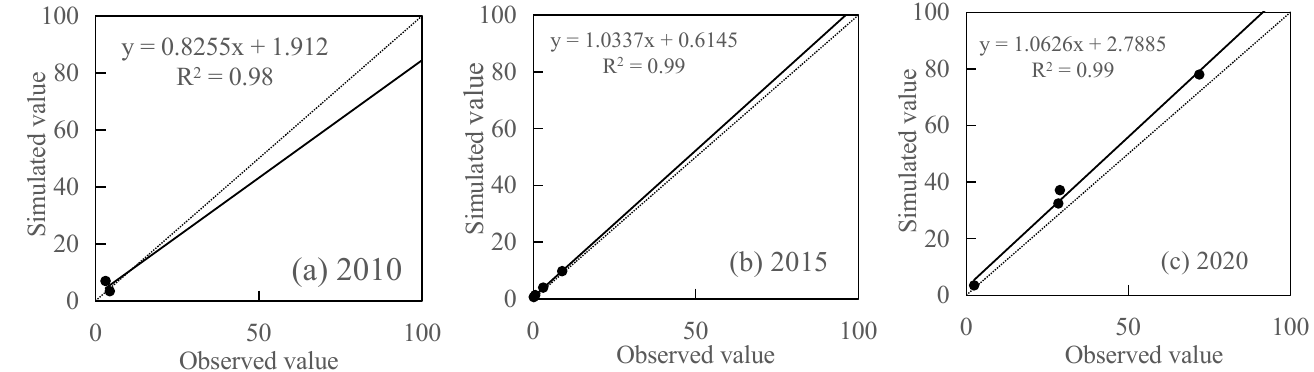
Figure 14. Correlation analysis between simulated value (10 5 t) and observed value (10 5 t) in ( a ) 2010, ( b ) 2015 and ( c ) 2020.